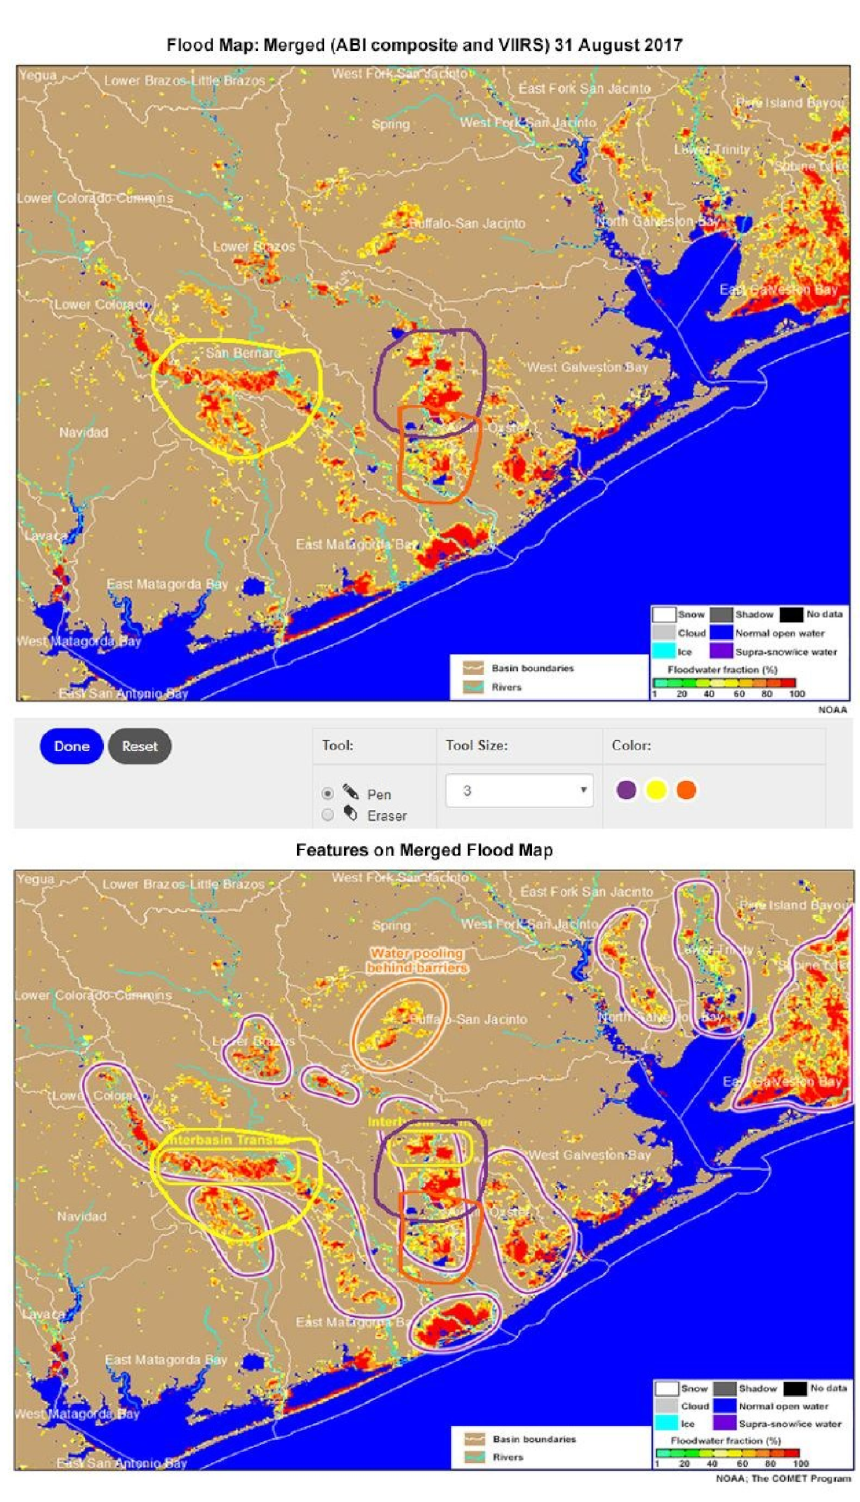
Figure 4. Drawing tool activity where learners are asked to locate and outline locations for types of flooding discernible in satellite imagery. The top image displays learner input while the bottom image presents the correct locations (with white shadowing on the outlines) paired with the locations the learner has drawn for comparison. To view this interaction online, go to https: // www.meted.ucar.edu / satmet / goes16_JPSS_hydro / navmenu.php?tab = 1&page = 3-3-0&type =